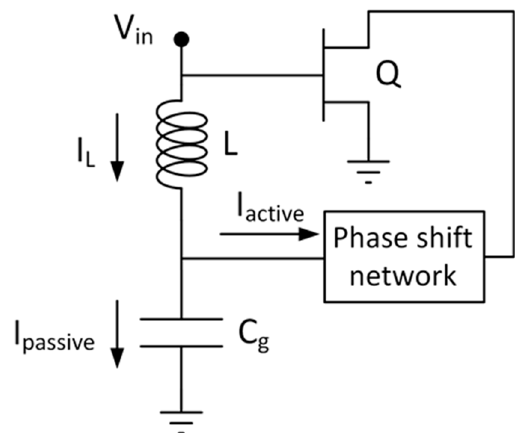
Figure 4. Improved topology of the AI for class-A low bias current.